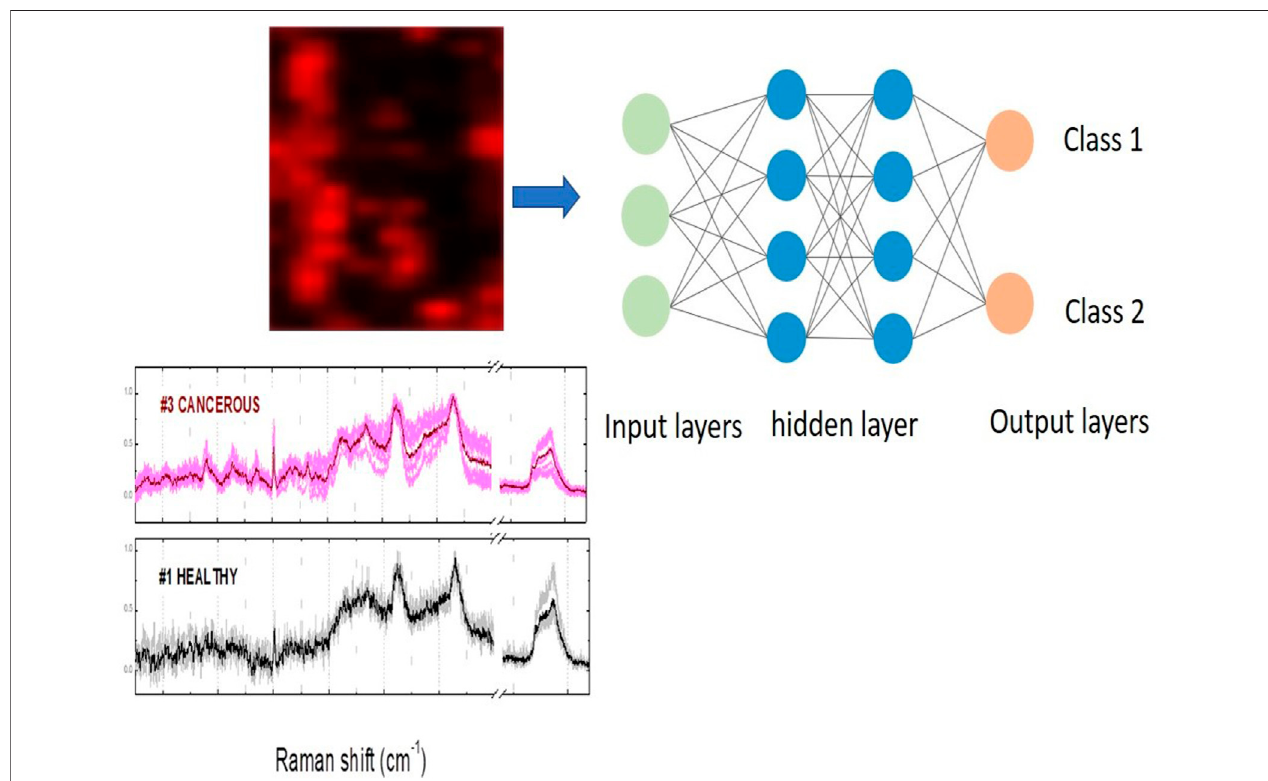
FIGURE2| Aschematic illustration ofmachine learningmethodology applied inRamanspectroscopy.Image featuresorspectral images areused asinputs tothe arti fi cial intelligence algorithm and the class output can be normal or tumour for discrimination between healthy and cancerous tissues.